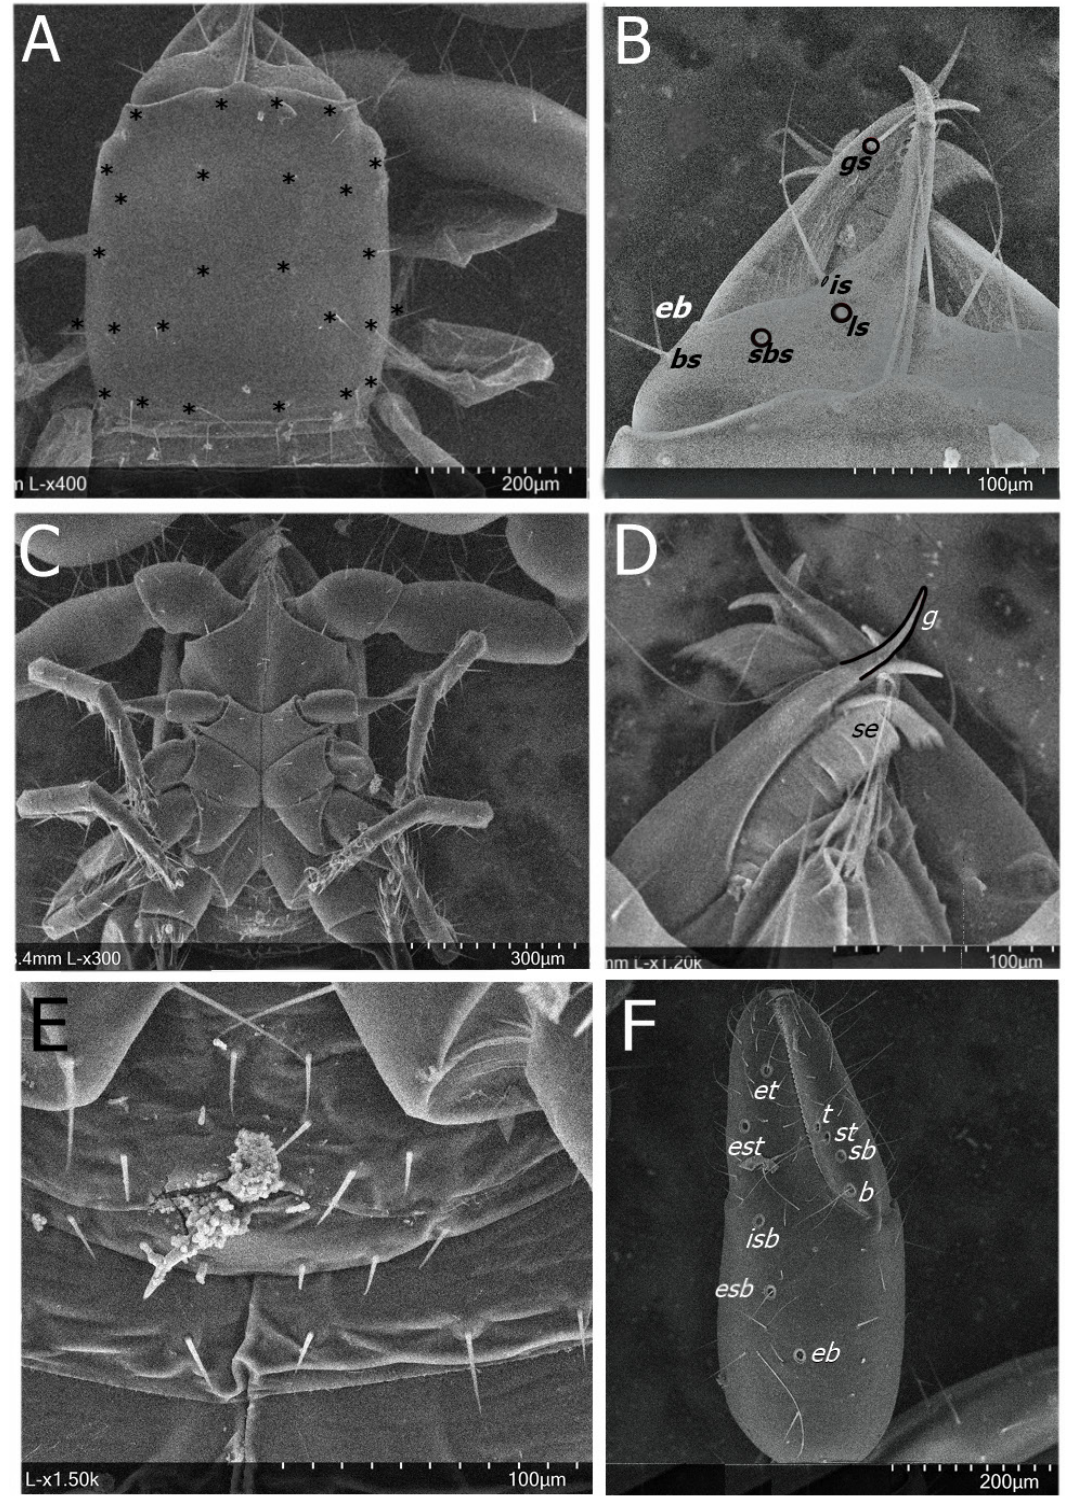
Fig. 16. Scanning electron micrographs of Ideobisium susanae sp. nov., paratype, ♂ (ZMH A0003693). A . Carapace with asterisks next to setae. B . Chelicera in dorsal view, showing trichobothria. C . Coxa. D . Chelicera in ventral view, showing galea and serrula exterior. E . Genital area. F . Chela in retrolateral view, showing trichobothria. Abbreviations: g = galea; se = serrula